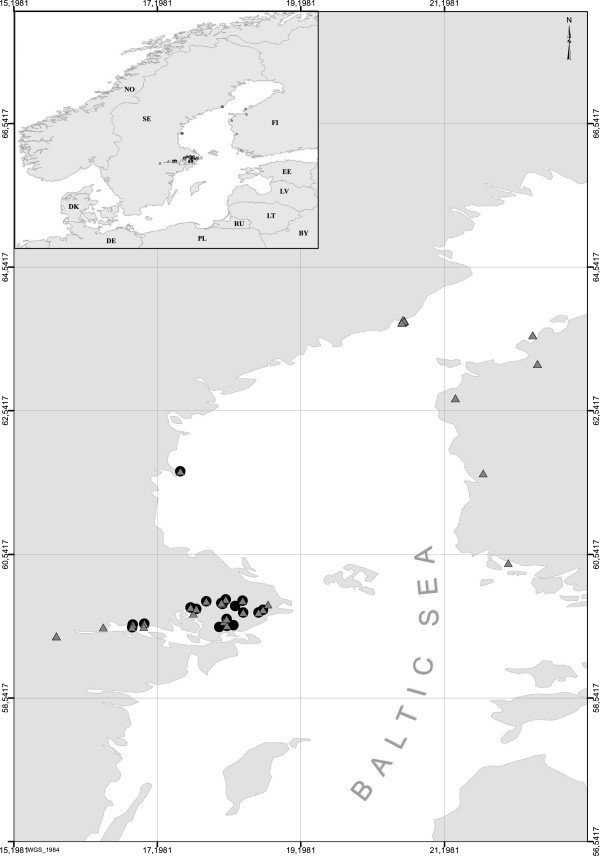
Sampling locations for Galerucella and Asecodes specimens in Sweden and Finland. Circles refer to sites were Galerucella were sampled and triangles refer to the collection sites of Asecodes.